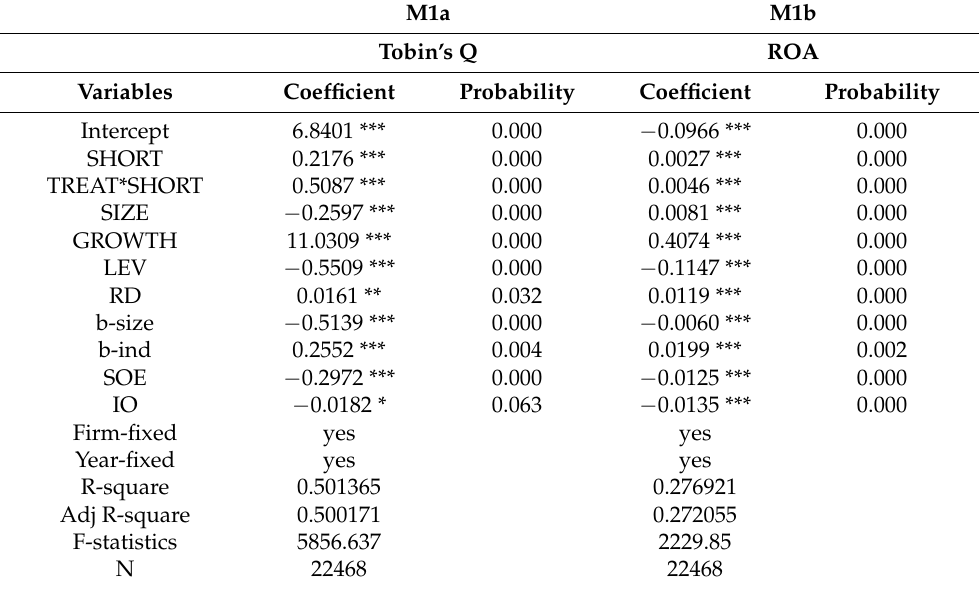
Table 5. Short-selling deregulation and firm